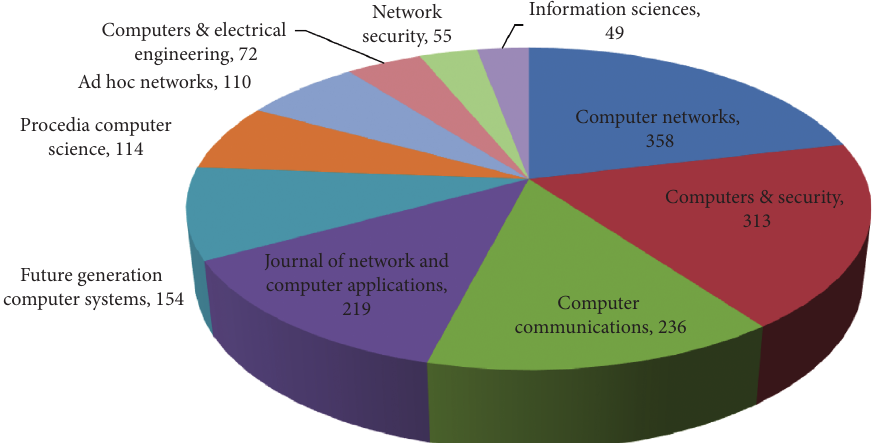
Figure 11: Content type and number of papers.